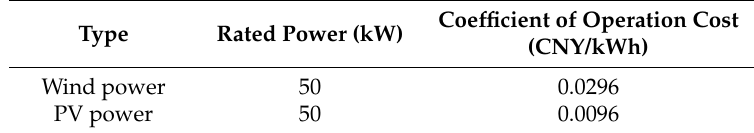
Table 3. Parameters of renewable energy sources.